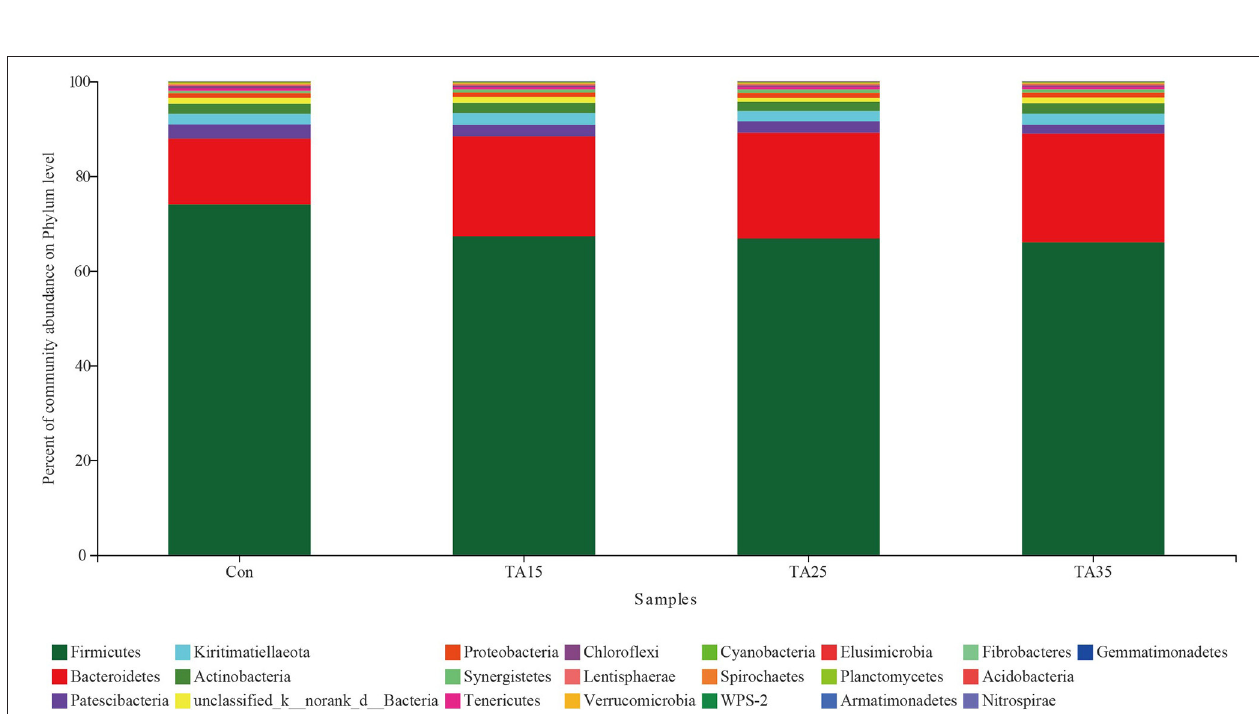
FIGURE 3 | Percentage composition of the total phyla in rumen fluid. CON, corn steeped in water; TA15, corn steeped in tannic acid solution of 15 g/l; TA25, corn steeped in tannic acid solution of 25 g/l; TA35, corn steeped in tannic acid solution of 35 g/l.